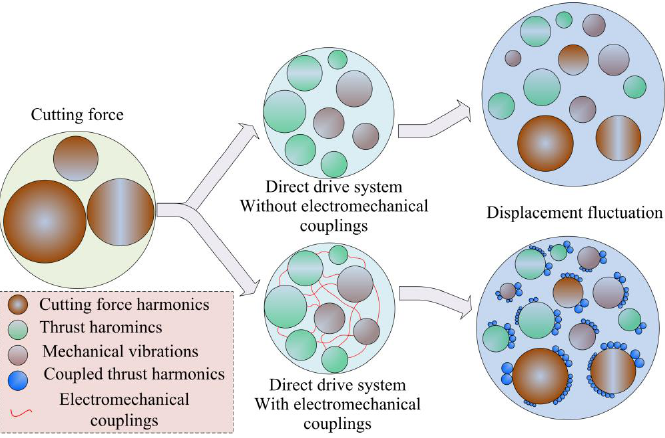
Figure 9. The effects of the machining process on the direct drive feed